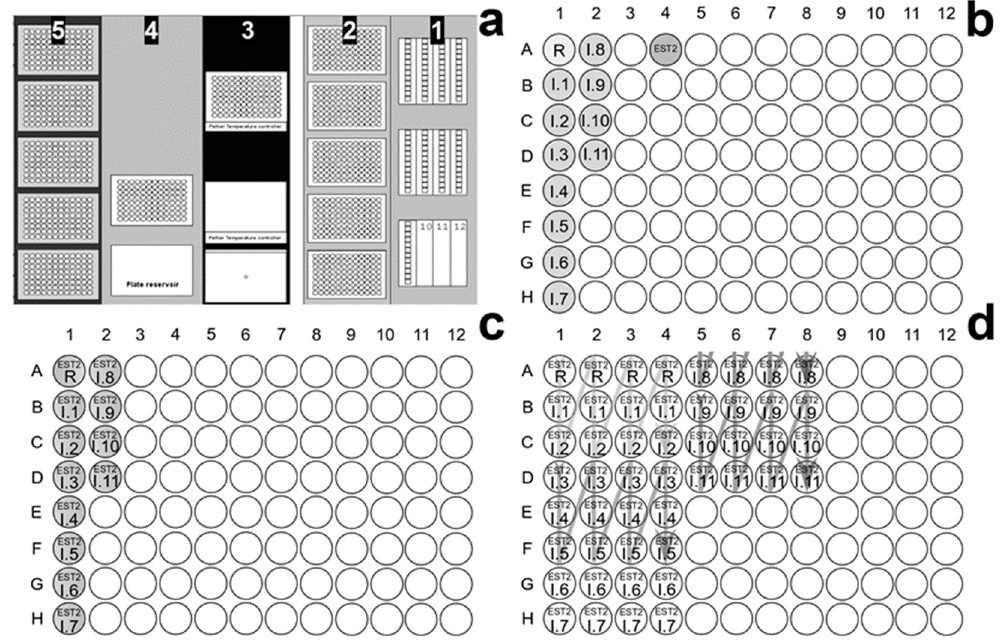
Figure 1. Representation of the robotic workstation worktable and plates layout for the measurement of EST2 residual activity. ( a ) In the worktable column 1 the solvent reservoir carriers, in column 2 disposable tip carriers (10, 200, 1000 µ L), in column 3 the stock solution and reagent plate in the temperature controller, in column 4 the incubation plate on the heated shaker, and in column 5 the plates for the enzymatic residual activity assays, were placed. ( b ) Plate placed in column 3 of ( a ), prepared by the operator manually, containing the enzyme (EST2) and the NBS treated OP inhibitors (I.1, I.2, ... I.n) and a blank reference (R). ( c ) Plate in column 4 of ( a ), containing the incubation mixtures (enzyme-inhibitors) prepared by the robotic liquid handler. ( d ) Plate layout in column 5 for the assays of enzymatic residual activity, samples are divided in three groups for the assay of each mixture. The arrows indicated the direction of measurements for each group of assays.